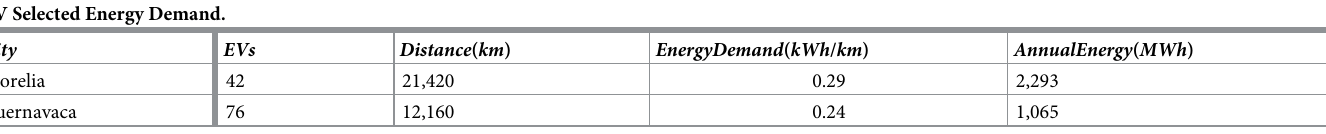
Table 7 shows the energy demand associated with the replacement of the entire current fleet of internal combustion vehicles by the selected electric vehicles according to electrical performance and required